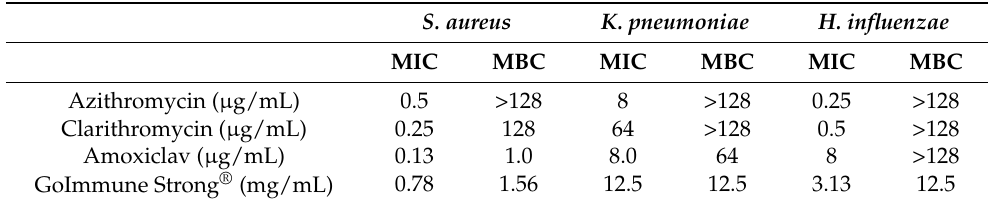
Table 5. Minimal inhibitory (MIC) and minimal bactericidal (MBC) concentrations GoImmune Strong ® complex and selected antibiotics.